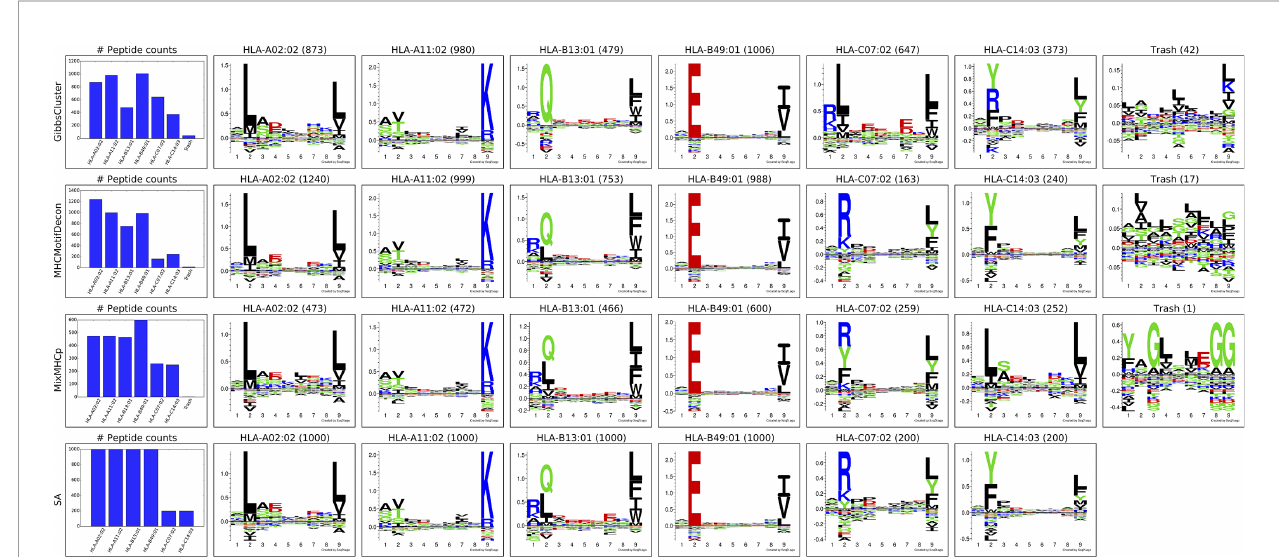
FIGURE 1 | Motif deconvolution of the arti fi cial HLA class I dataset. GibbsCluster, MHCMotifDecon, MixMHCp deconvolution of datasets. Motifs for MixMHCp were constructed from the set of deconvoluted 9mer peptides only. The lower panel (SA) shows motifs for each individual HLA-A*02:02, HLA-A*11:02, HLA-B*13:01, HLA-B*49:01, HLA-C*07:02, HLA-C*14:03 dataset as obtained by GibbsCluster using a single